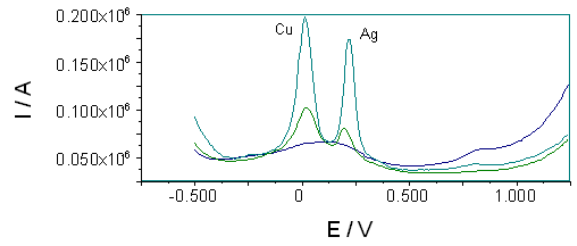
Figure 4: Differential pulse anodic stripping voltammograms obtained for determination of Ag + and Cu 2+ in mixture of BR buffer at pH 4.1 / ethylene glycol (100/1, v/v) on glassy carbon electrode.